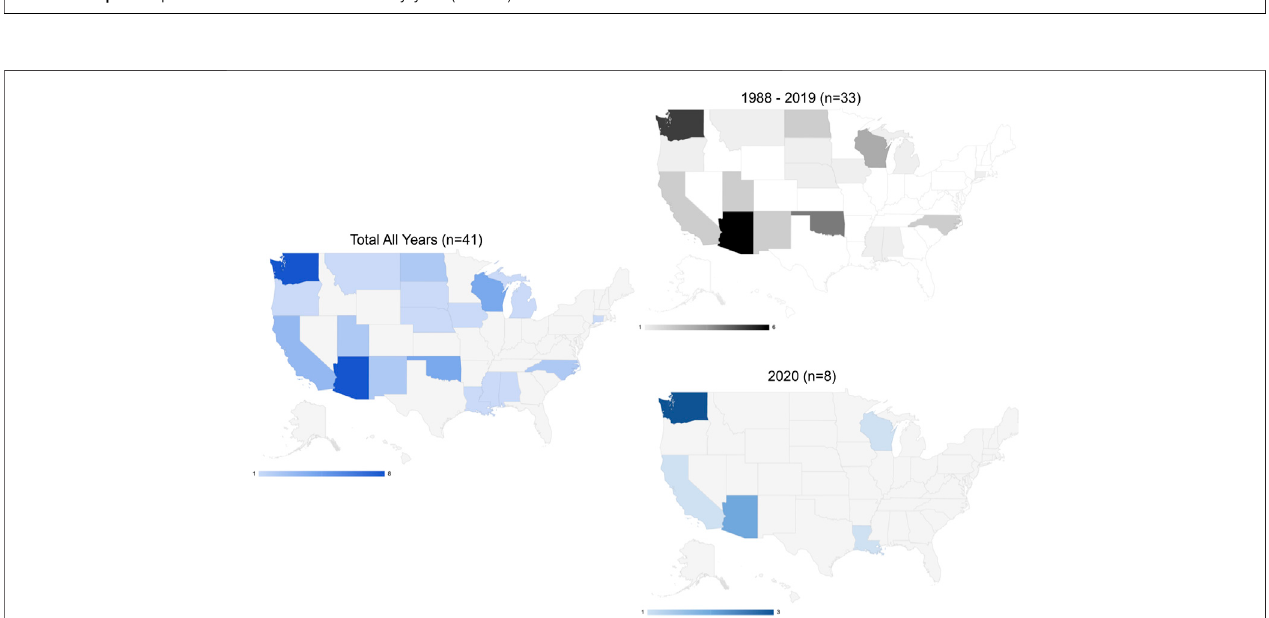
FIGURE 2 | Tribal public health codes by state ( N (cid:1) 41).